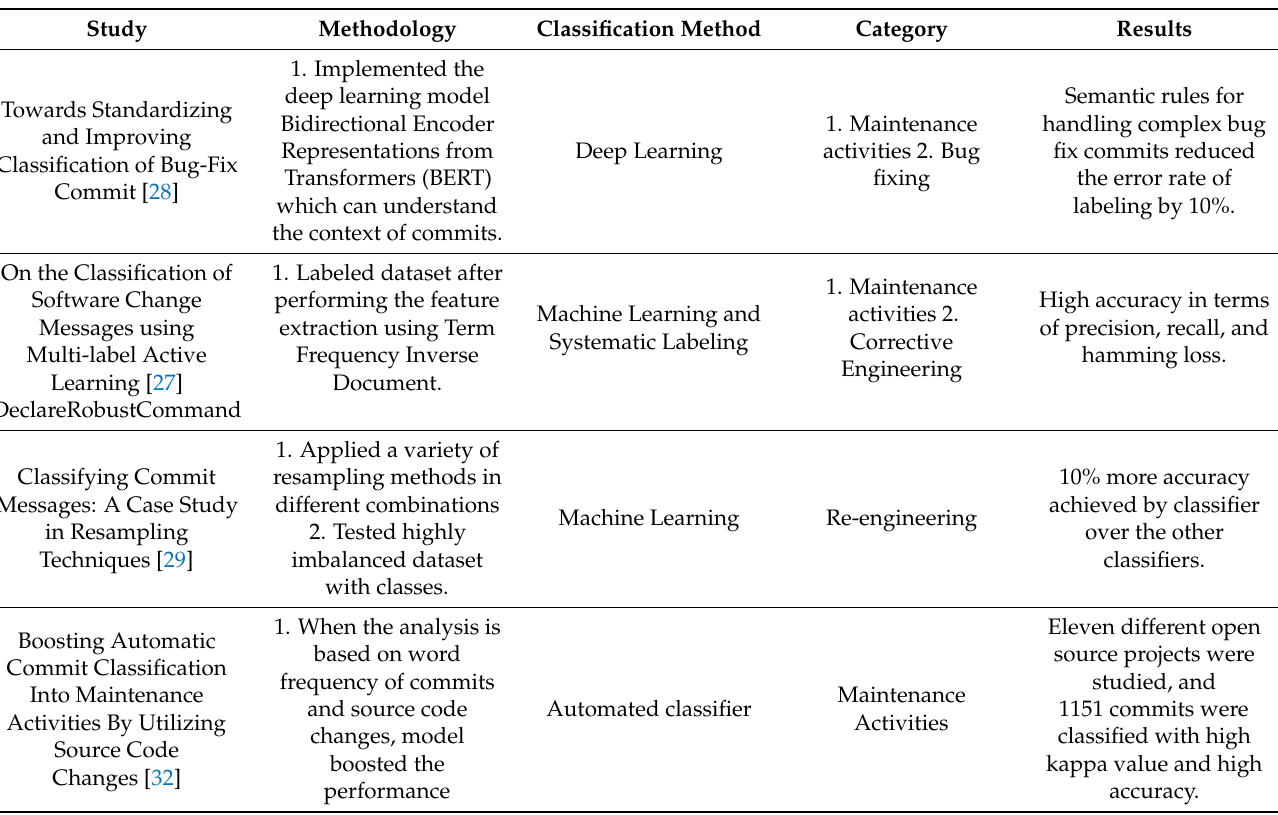
Table 1. Summarized literature